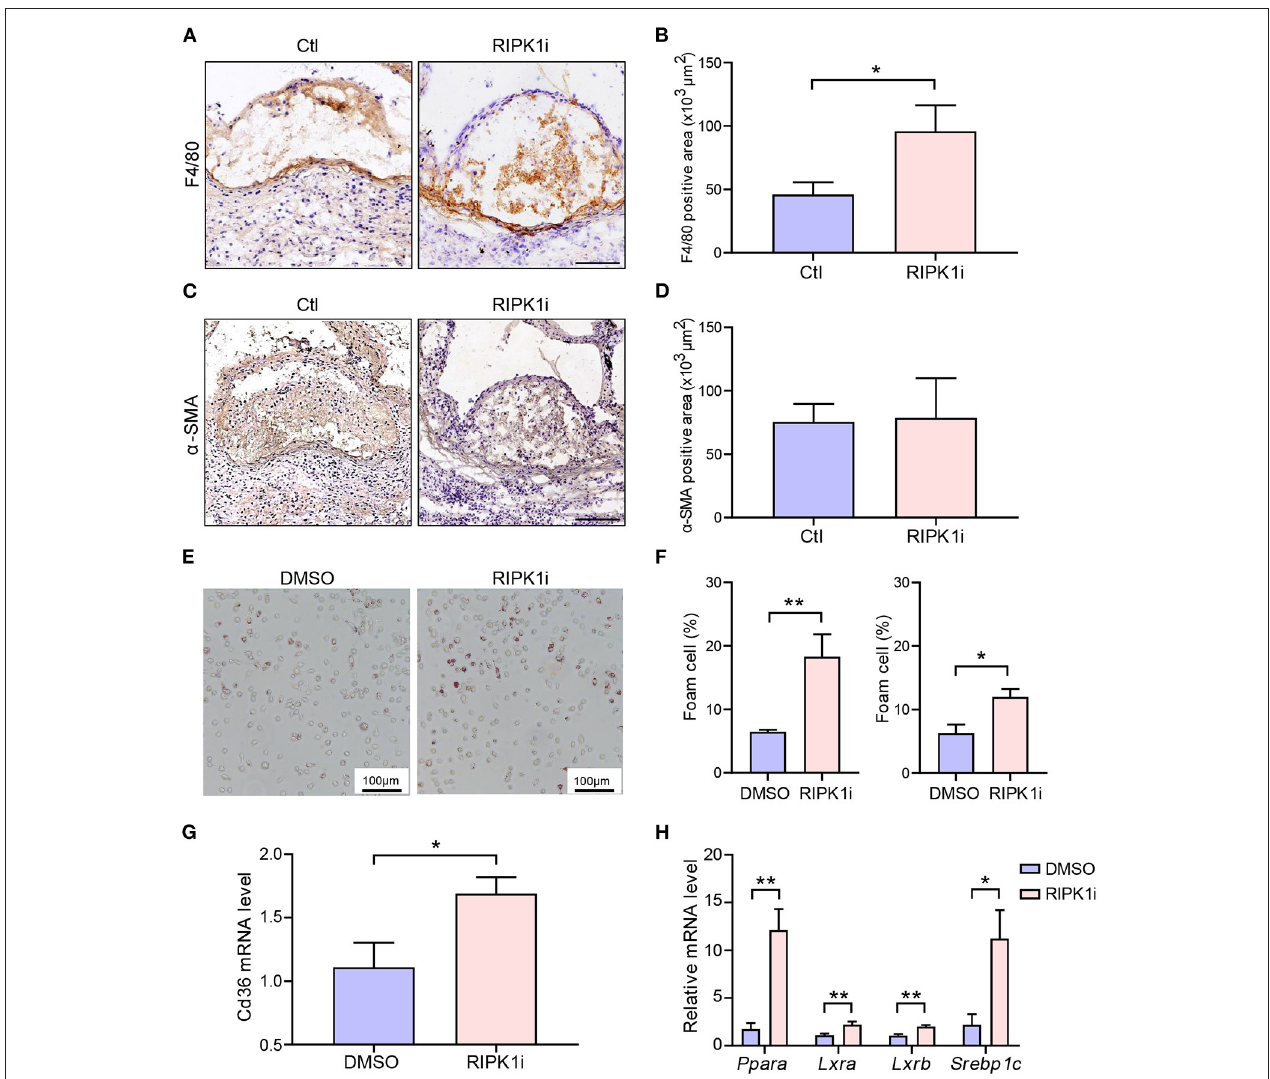
FIGURE 4 | RIPK1i accelerated macrophage accumulation and foam cell formation. (A–D) Histological analysis of cross-sections from aortic sinus of ApoE SA / SA mice receiving RIPK1i for 4 weeks. n = 5 mice per group. (A) Representative IHC images of F4/80 in aortic sinus plaque. Scale bar = 100 µ m. (B) Quantification of macrophages (F4/80 positive) are represented. (C) Representative IHC images of α -SMA in aortic sinus plaque. Scale bar = 100 µ m. (D) Quantification of smooth muscle cells ( α -SMA positive) are represented. (E–H ) Peritoneal macrophages isolated from male ApoE SA / SA mice or male C57BL/6J mice were pretreated with RIPK1i (50ng/ml) or DMSO for 3h, then stimulated with oxidized LDL (50 µ g/ml) for 24h. (E) Representative images of Oil Red O stained foam cells for male ApoE SA / SA mice. (F) Percentage of foam cells in ox-LDL induced peritoneal macrophages for male ApoE SA / SA mice (left, n = 5) and male wild-type mice (right, n = 3). (G) Relative Cd36 mRNA level in ox-LDL induced peritoneal macrophages for male ApoE SA / SA mice ( n = 6). (H) Lipid metabolism-related genes expression levels in ox-LDL induced peritoneal macrophages for male ApoE SA / SA mice ( n = 5–6 per group). All of the data represented as mean ± SEM; * P < 0.05, ** P < 0.01. Statistical analysis: unpaired student’s t -test (B,G) , non-parametric Mann-Whitney U test (F,H)